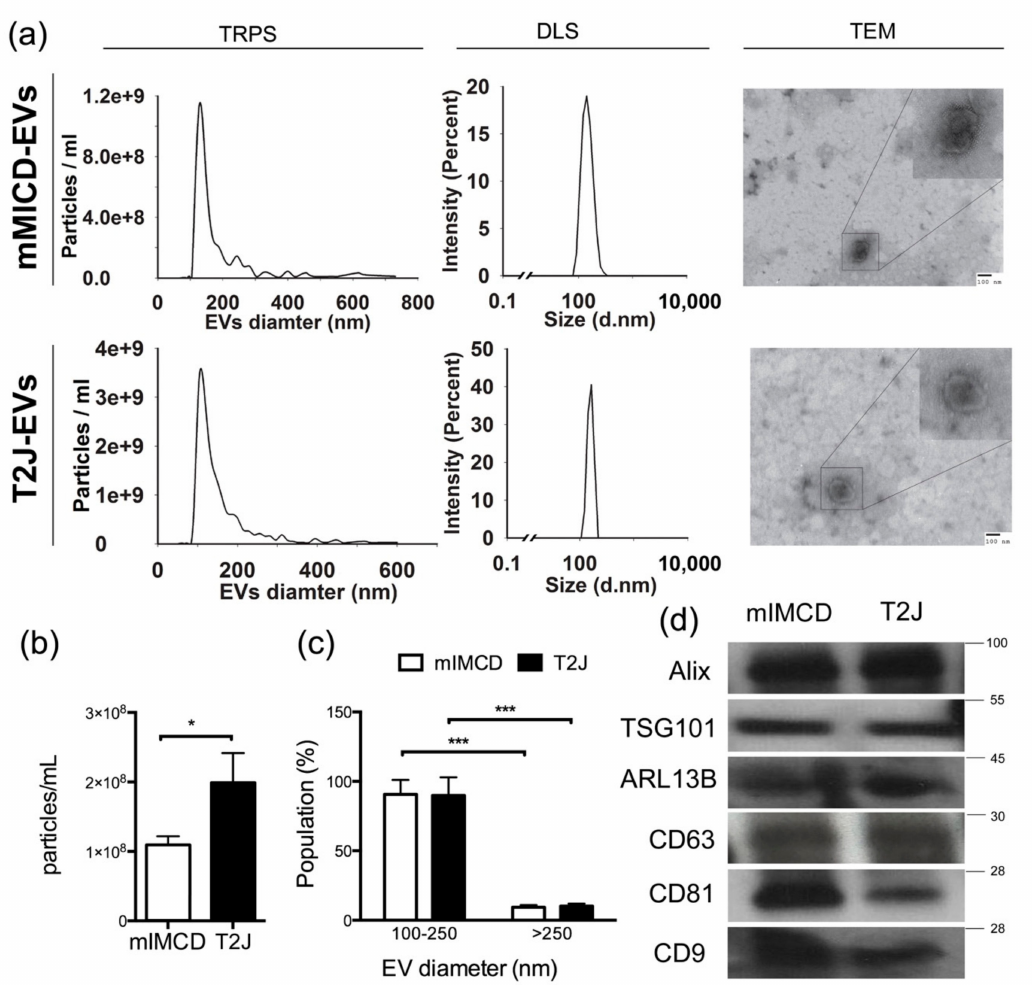
Figure 2. Characterization of mIMCD and T2J Cell-Derived EVs. ( a ) Three methods were used to describe size of EVs derived from mIMCD (top) and T2J cell lines (bottom). TRPS: tunable resistive pulse sensing, DLS: dynamic light scattering and TEM: transition electron microscopy. ( b ) Average concentration of EVs isolated form six independent cell media of mIMCD and T2J cells. ( c ) Approximately 88–91% of total EVs Recovered from mIMCD and T2J cell lines are smaller in size (100–250nm). ( d ) Six di ff erent final elutes from each cell lines were pooled together and concentrated, a maximum volume of 42 µ L of EVs suspension were lysed and separated. Western blot analysis of EVs isolated from conditioned media of mIMCD and T2J cell lines shows the presence of traditional EVs markers Alix, TSG101, CD63, CD81, and CD9. Note: (* p < 0.05, and *** p <